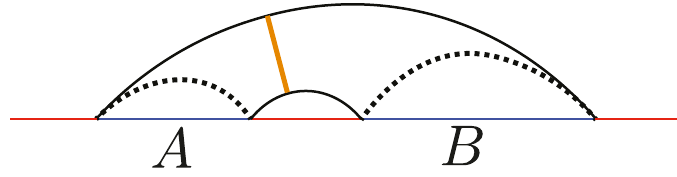
Figure 2 . Subregion AB at the threshold of a mutual information phase transition. There are two competing RT surfaces, denoted by solid and dashed black lines. The area of the dashed lines is equal to the area of the solid lines. EW ( A : B ) before the transition is denoted by a solid orange line, while it vanishes after the